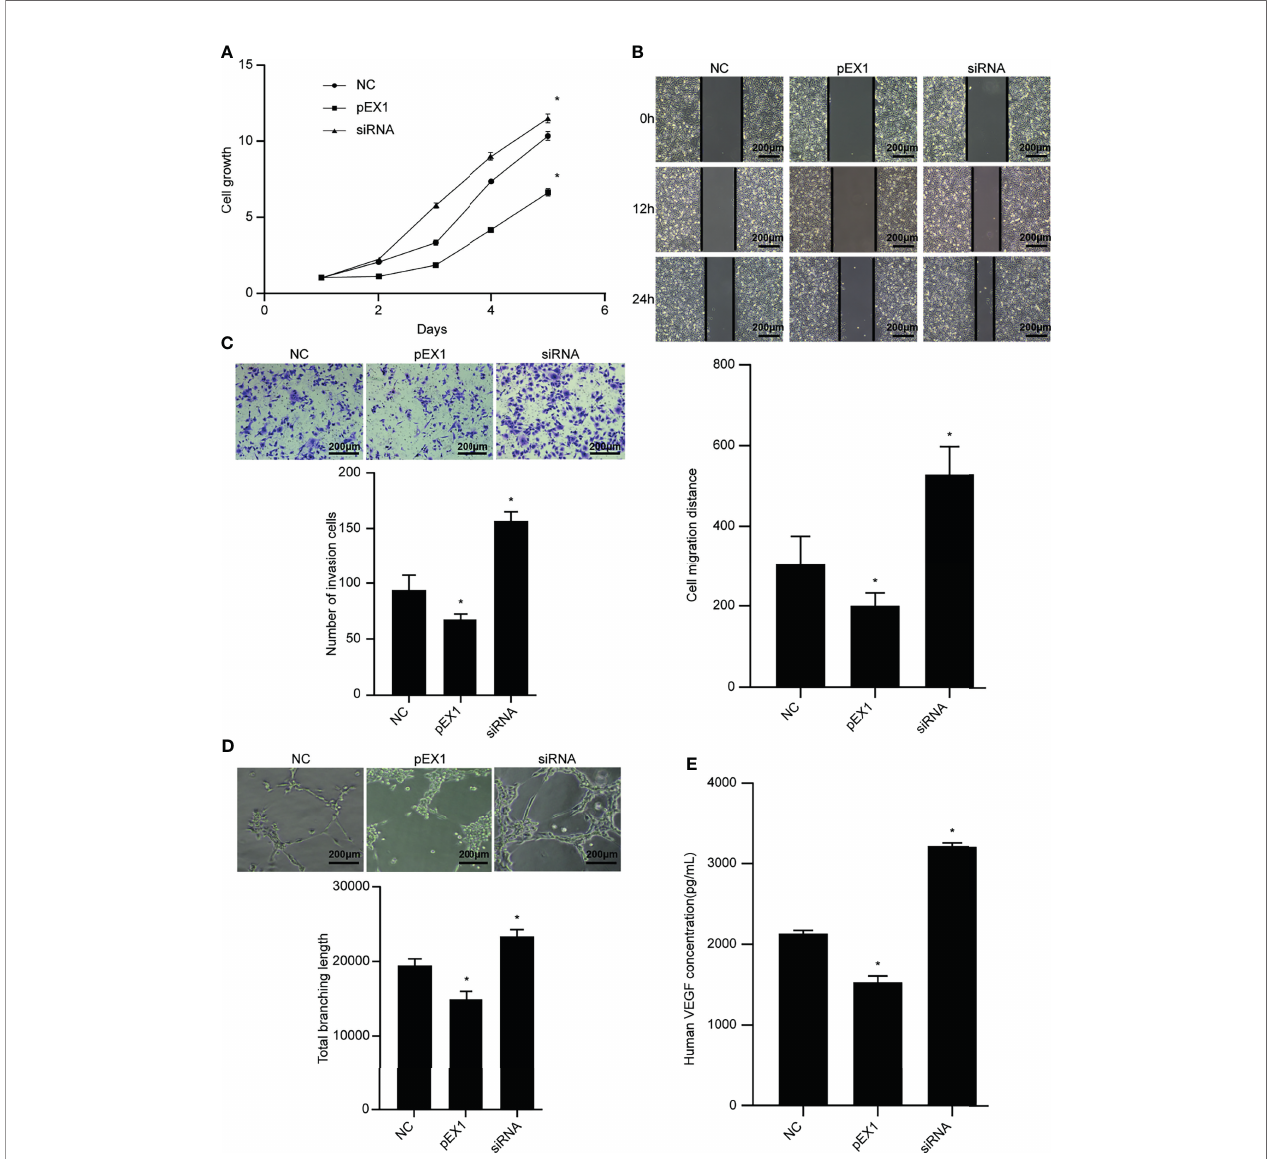
FIGURE 7 | Biological functions of TECs in each group. (A) Cell proliferation ability after TECs were cultured in different conditioned media; (B) Cell migration ability after TECs were cultured in different conditioned media (100×); (C) Cell invasion ability after TECs were cultured in different conditioned media (100×); (D) Tube- forming ability after TECs were cultured in different conditioned media (100×); (E) VEGF secretion after culturing TECs in different conditioned media. (siRNA group: S2 sequence). * p < 0.05 compared to the NC